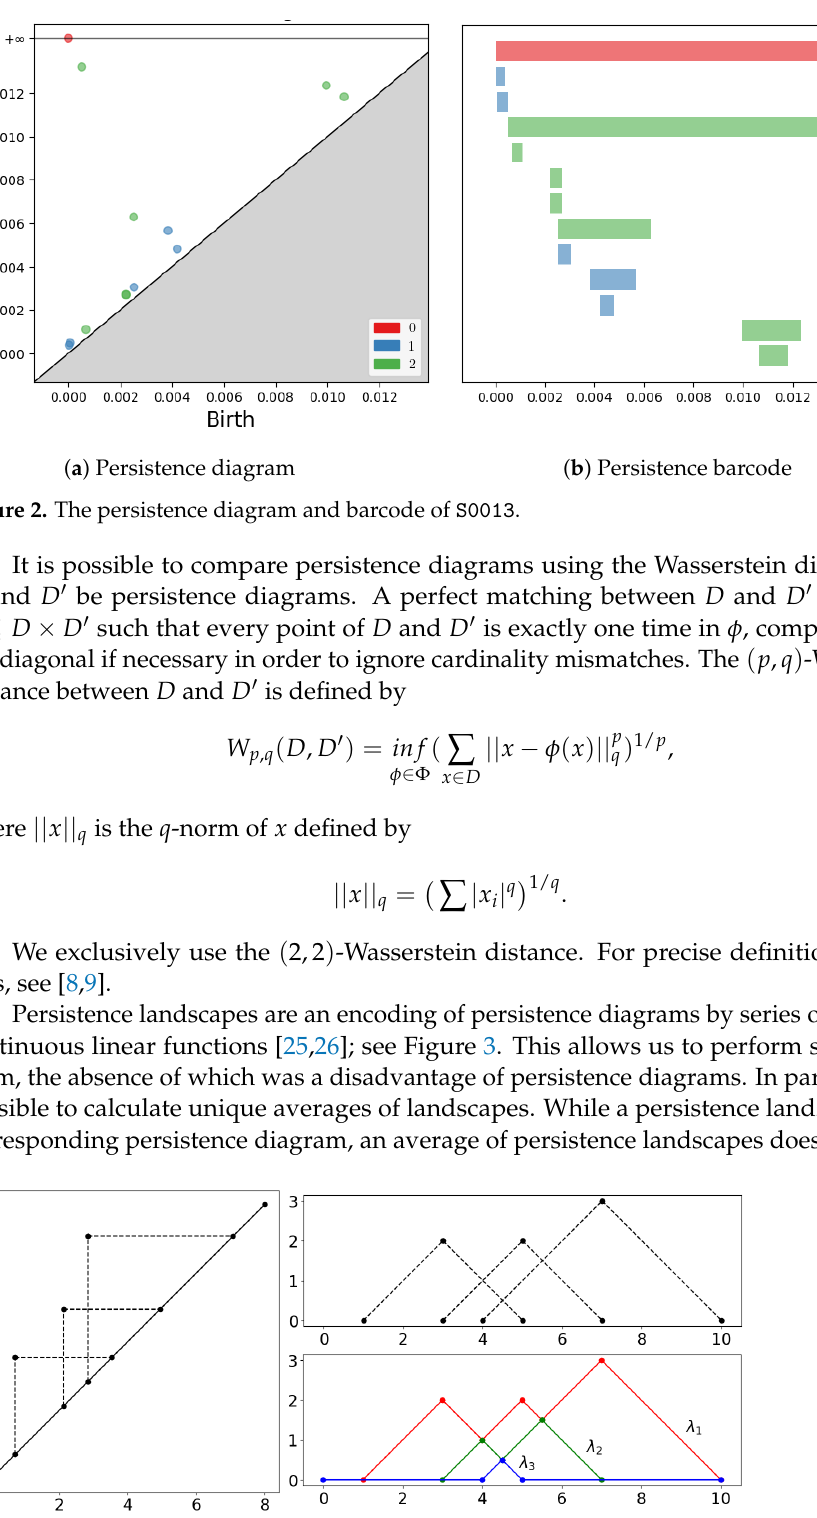
Figure 3. Visual explanation of persistence landscapes. The persistence diagram ( left ) is tilted so that the diagonal becomes the new horizontal axis ( top right ). The λ i are the piecewise linear functions ( bottom right